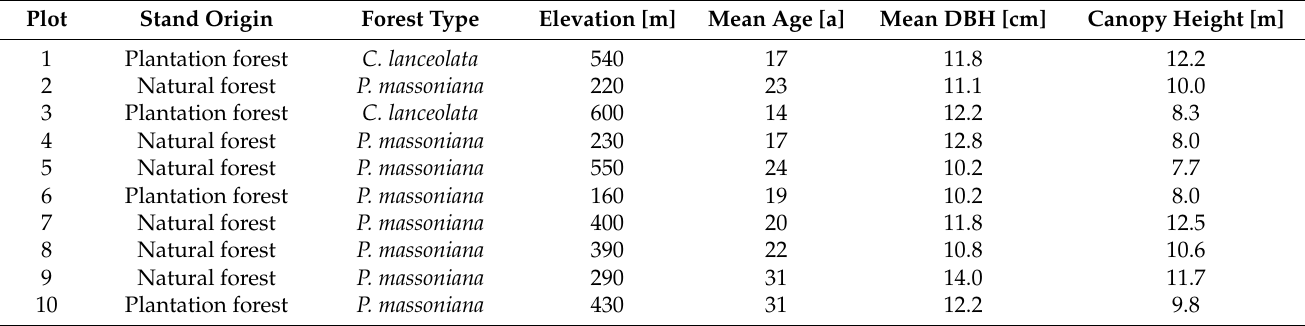
Table 1. Descriptions of subtropical coniferous forest plots in the